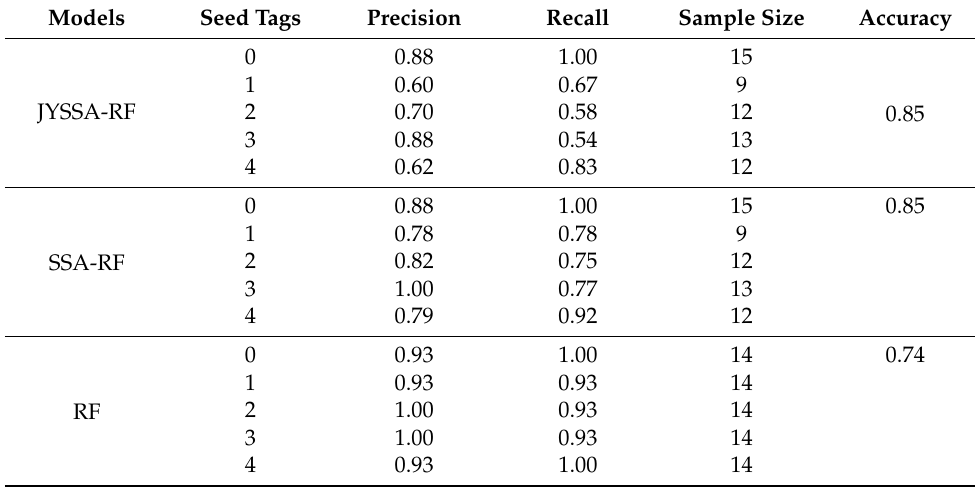
Table 5. Results of the three model test sets in the 186